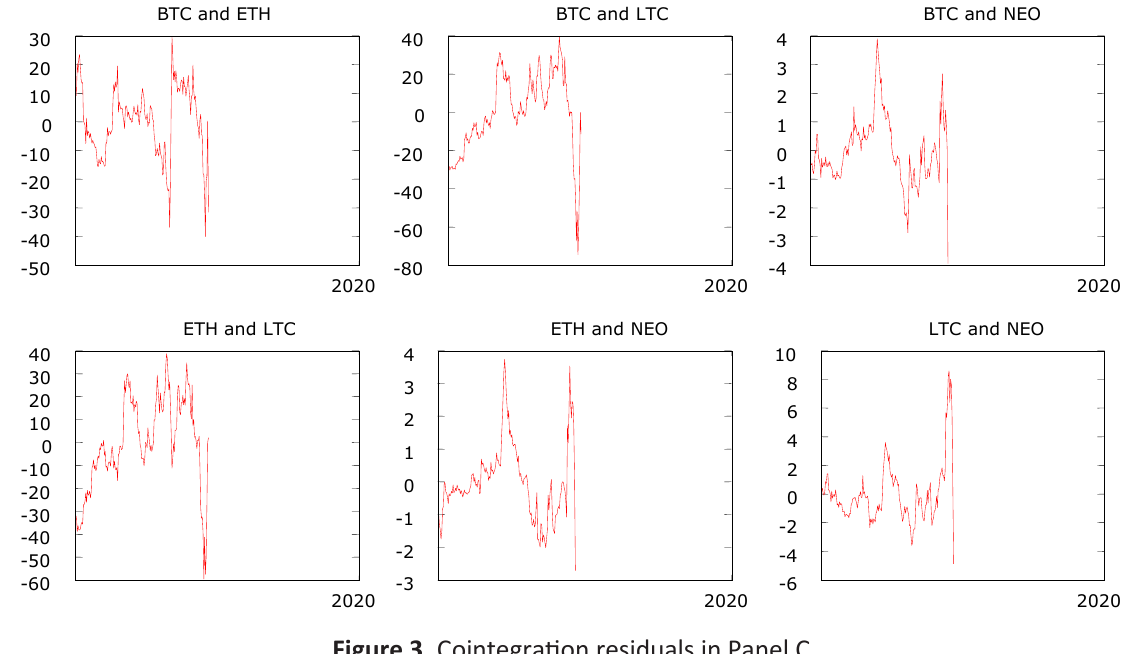
Figure 3. Cointegration residuals in Panel